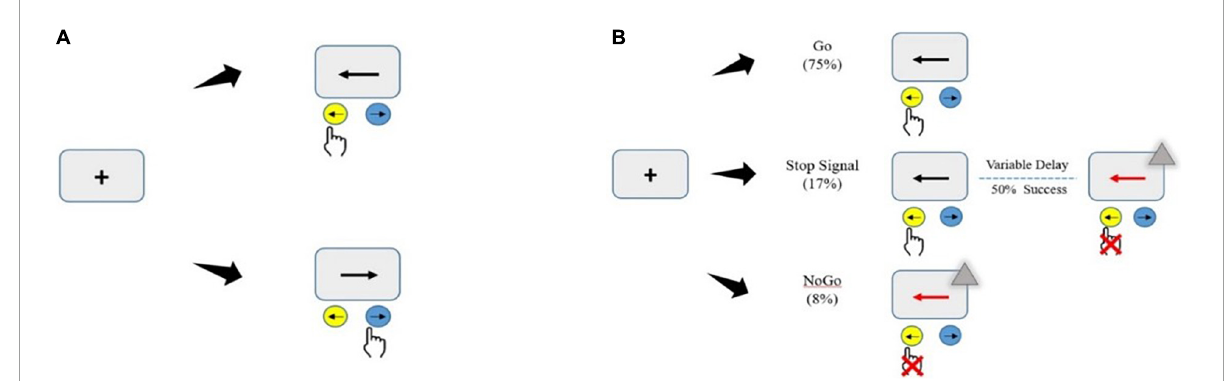
FIGURE3 Illustration of the motor inhibition tasks. Subjects sat in a relaxed position (with the elbows, hips, and knees flexed at 90–100 ◦ ) in front of a computer with a monitor in their line of sight at a distance of 75 cm. Before the test, the subjects were instructed about the experiment and completed a practice test to become familiar with the experimental task. Then, they entered the formal experiment stage and randomly completed two experimental tasks. (A) Never stop task (360 go-only trials). (B) Maybe stop task (pseudorandom mix of 75% go trials, 17% stop trials, and 8% no-go trials). The gray triangle served as the visual stop